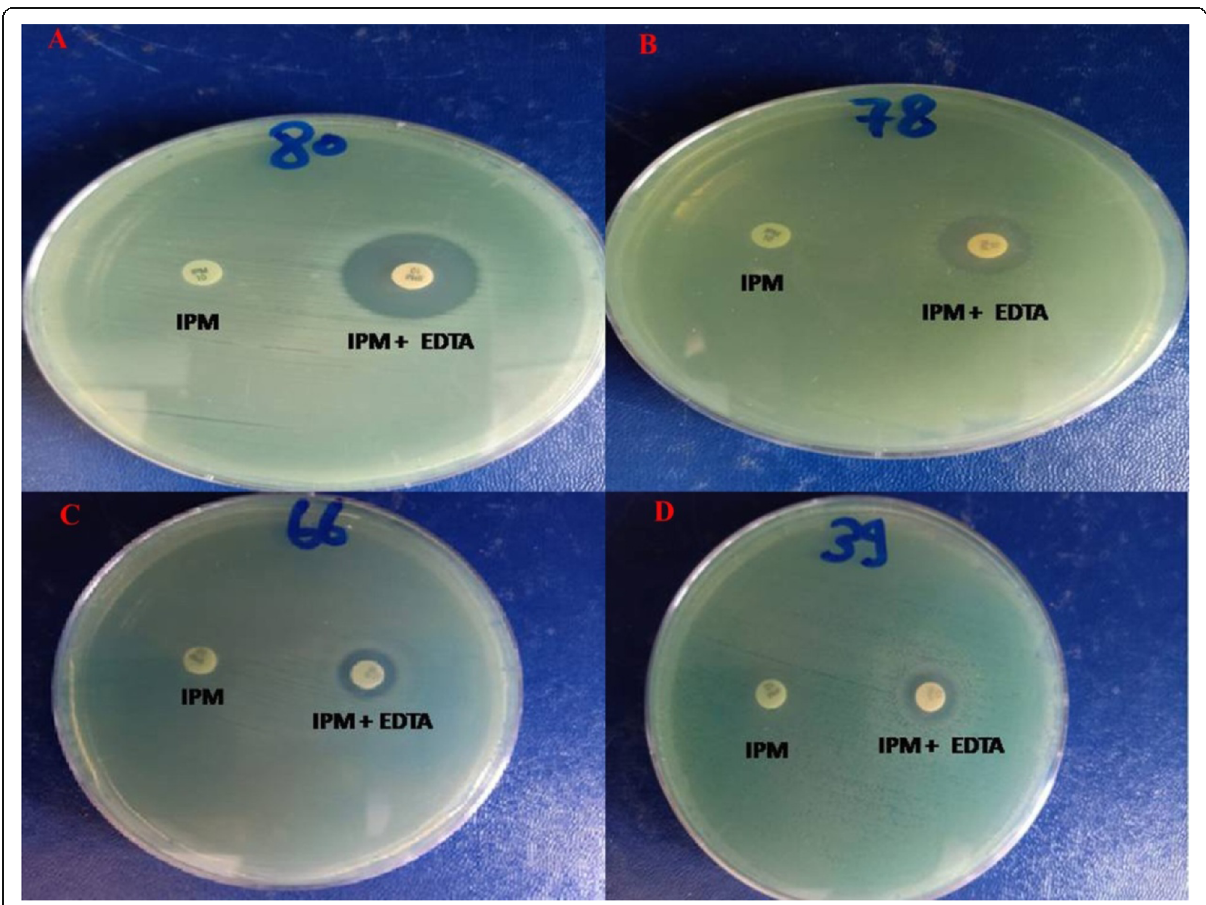
Fig. 3 Combined disk assay (MBL-CD) exhibited increases in the zone of inhibition around IPM + EDTA disc interpreted as MBL